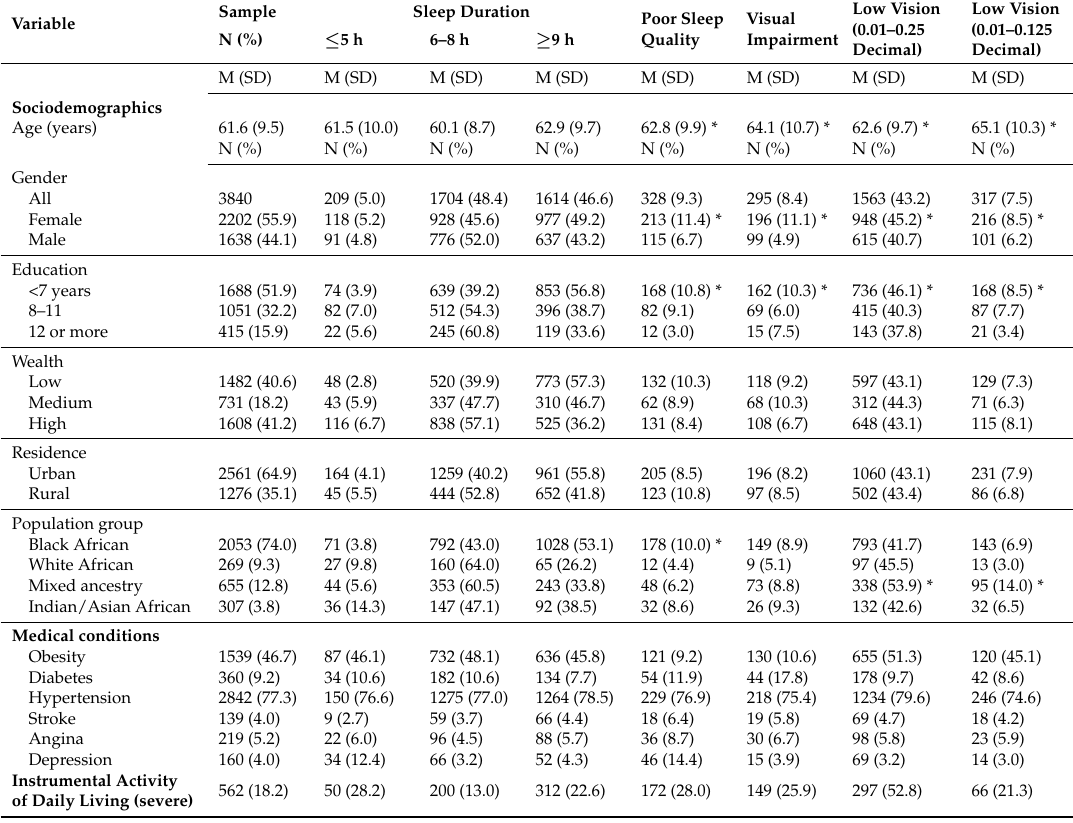
Table 1. Sample characteristics, sleep pattern and